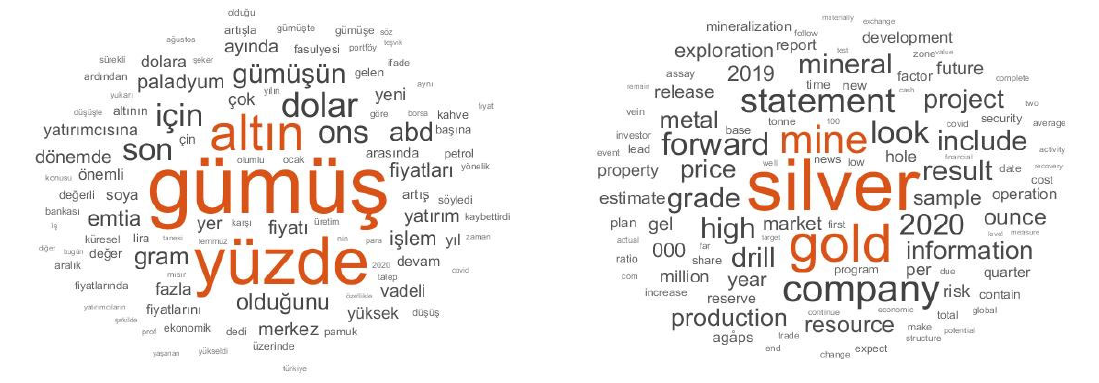
Fig. 4. Words Related to Silver in Turkish Fig. 5. Words Related to Silver in